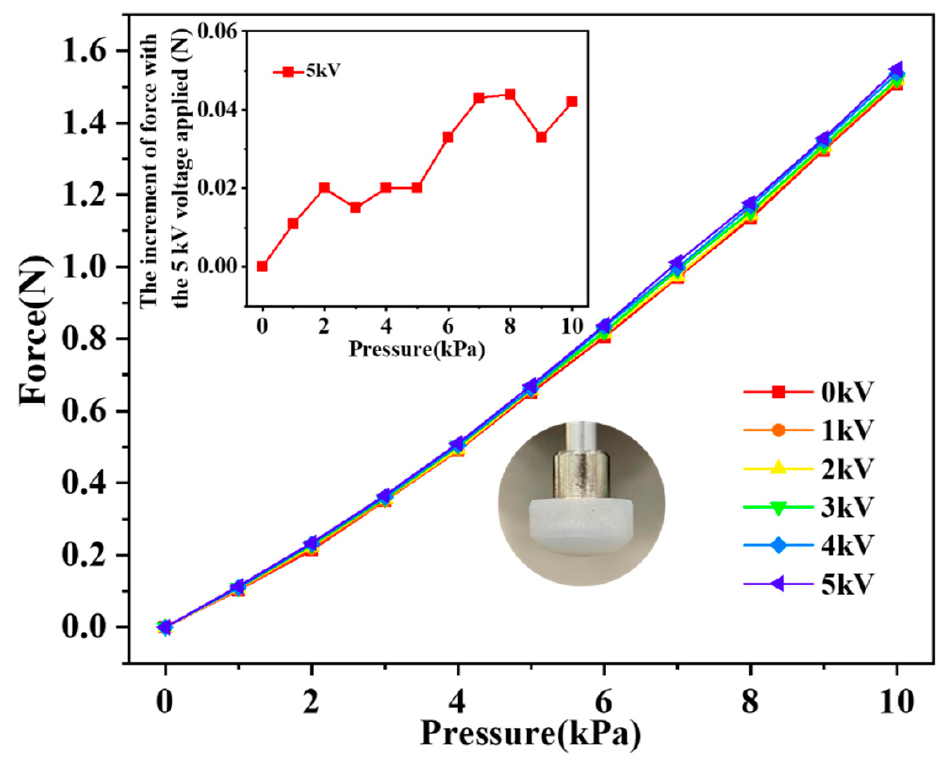
Figure 7. The output force of the SEHPA under different pressures and voltages. The inset shows increment in the output force at 5 the increment in the output force at 5 kV.